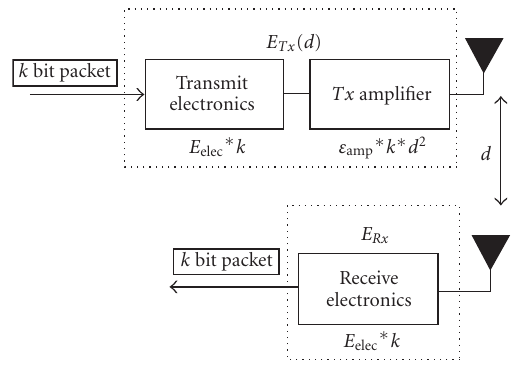
Figure 2: TX/RX channel transmission model (from